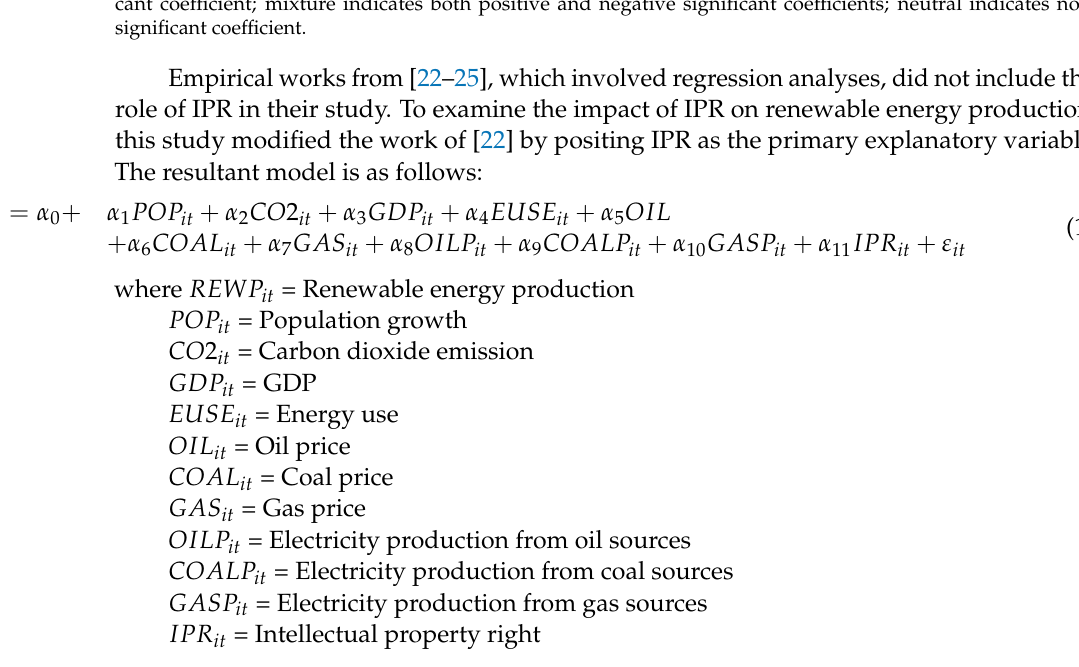
Table 1. Factors driving renewable energy production in the literature. Explanatory Variable [22] [23] [24] [25] GDP Mixture - Neutral Positive CO 2 Emission Negative Negative Positive - Energy Use Positive Positive Negative Positive Oil Price Mixture - Mixture Mixture Coal Price Mixture - Neutral Mixture Gas Price Positive - Neutral Negative Note: Positive indicates a positive and significant coefficient; negative indicates a negative and signifi- cant coefficient; mixture indicates both positive and negative significant coefficients; neutral indicates non- significant